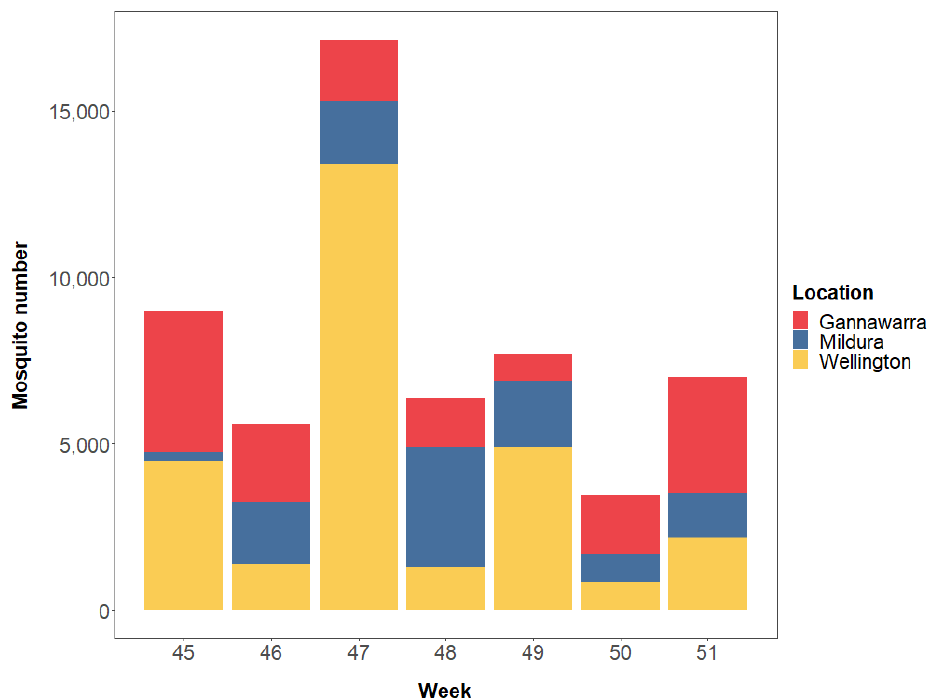
Figure 2. The estimated total number of mosquitoes used for sequencing per location per week from 7 November 2016 (Week 45) to 19 December 2016 (Week 51).